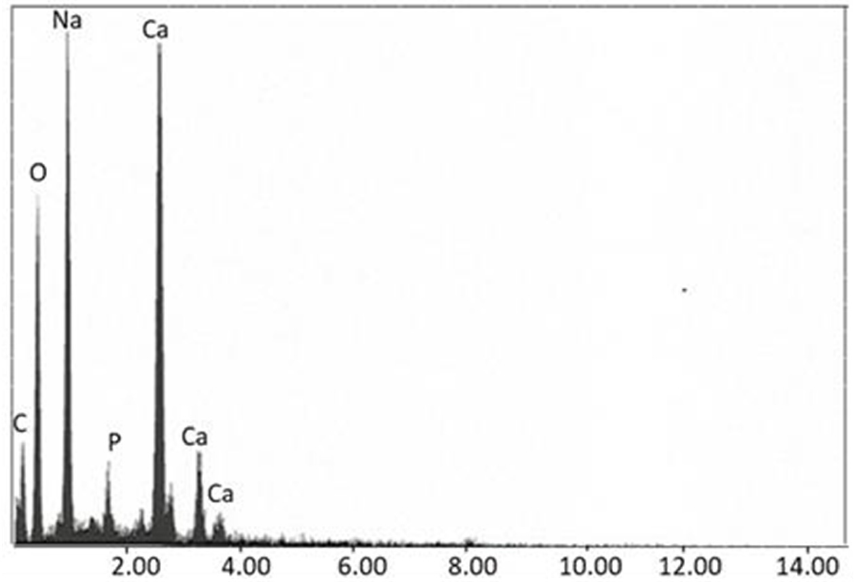
Figure 14. EDX spectrum of TiO 2 scaffolds with pork bone in